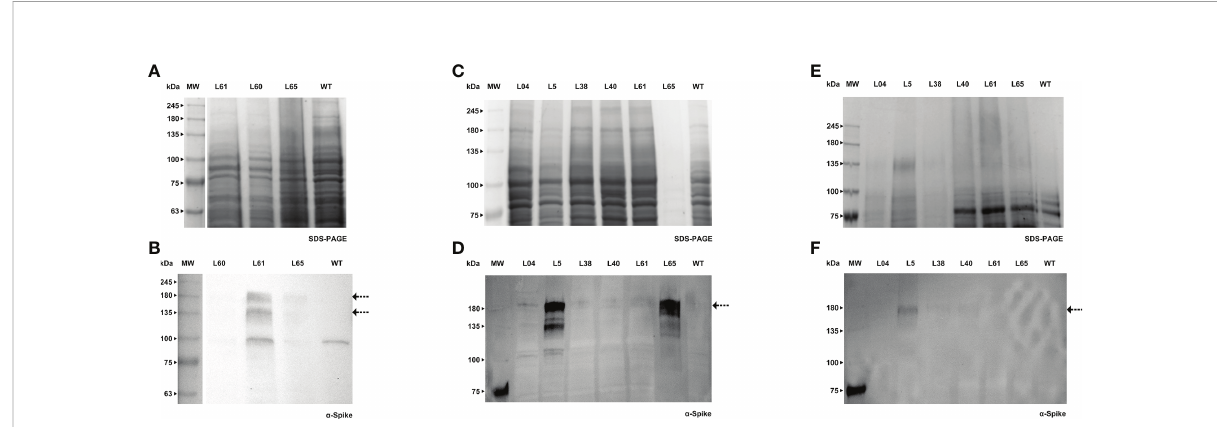
FIGURE 6 Detection of Spike recombinant protein in calli (A, B) , cell extracts (C, D) and spent medium (E) of Medicago. (A) Stained gel containing total protein extract of three calli of Medicago, WT - wild type. (B) Corresponding WB with anti-Spike antibody. (C) Stained gel containing cellular extract of six independent Medicago cell lines, WT - wild type. (D) Corresponding WB with anti-Spike antibody. (E) Stained gel containing spent medium of six independent Medicago cell lines with anti-Spike antibody, WT – wild type. Samples were concentrated with a centrifugal fi lter (L04 – 18x, L5 – 38x, L38 – 38x, L40 – 32x, L61 – 27x, L65 – 16x). (F) Corresponding WB anti-Spike